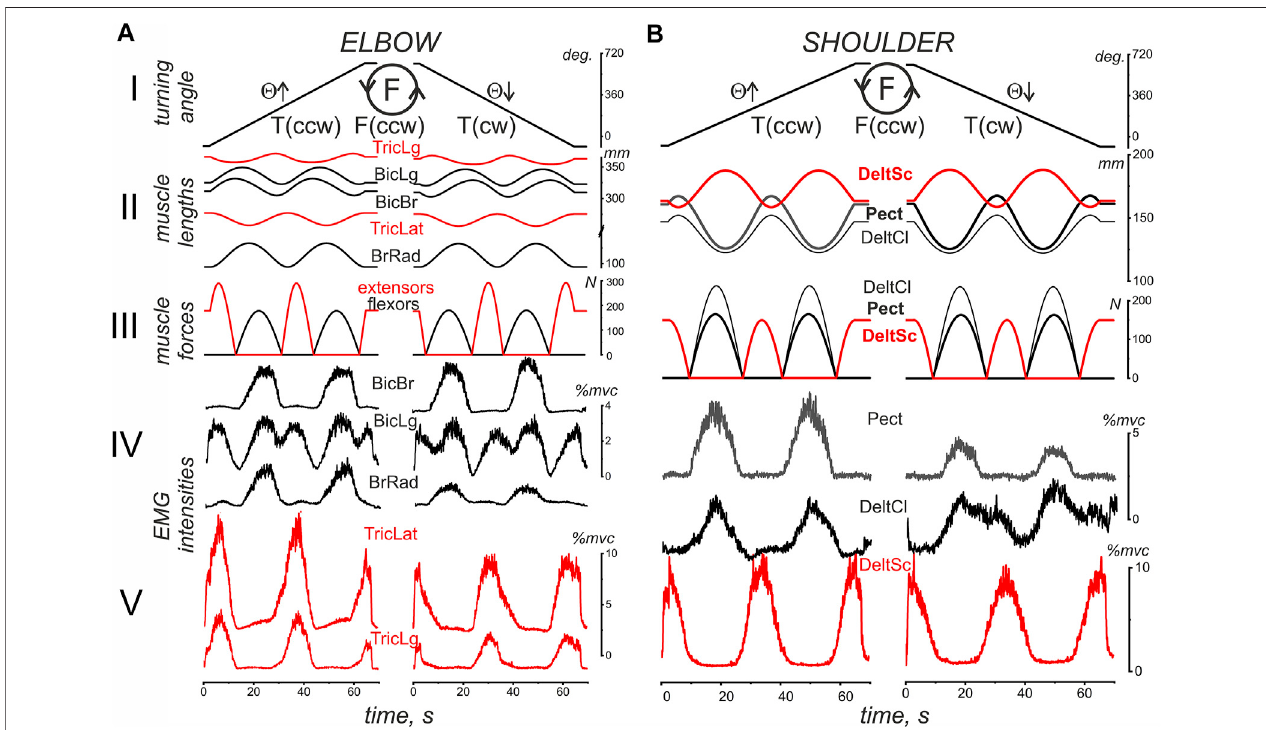
FIGURE 2 | An example of typical recordings of EMG activity in the fl exor (black) and extensor (red) muscles (subject YK with identi fi ed bone geometry). The muscles belong to the elbow (A) and shoulder (B) joints during standard test movements, including the creation of counterclockwise hand force (F inside the drawn circle); the same movement program (not shown in this panel) is then repeated for a clockwise direction of force. The movement trajectory of the handle under the subject ’ s right hand (H), which has been de fi ned by the program of the related turnings of the step motors, is presented as the turning angle ( Θ ) of the handle ’ s positionat thecircular trace; theEMGreactions during therising( Θ ↑ ) and falling ( Θ ↓ ) branchesofmovement areconsidered separately. Thepressure onthe handle was created by a subject in accordance with an arbitrary contraction program (ACP) that was prepared in advance together with the imposed movement program (IMP) for the handle transitions of the mechatronic mechanostimulator (MMS). The muscle lengths and forces were evaluated in an off-line regimen using a corresponding model approach based on the 3D prints of the bones of this subject (Gorkovenko et al., 2020), therefore the presented single records of force and length correspond to all identical movements used forfurtheraveraging procedure ofthe EMGrecords in sixrepetitions ofthe tests (seeMethods). Note thedifferentcalibrationscalesfor EMGs recorded from different